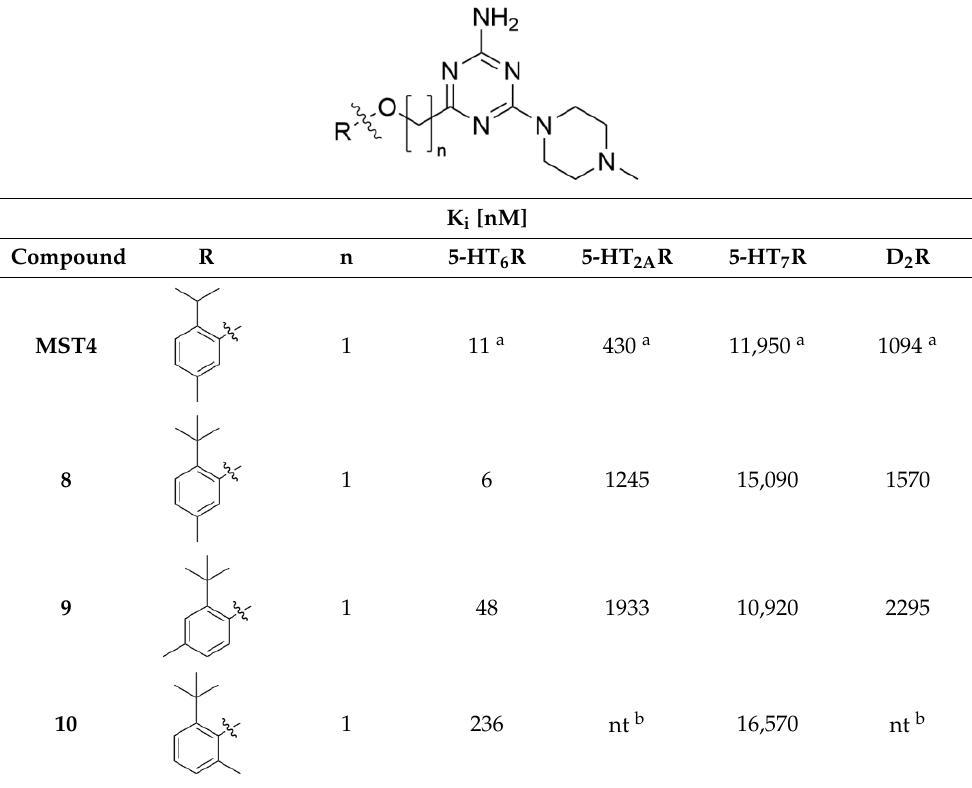
Table 2. Structures and biological activity of tested compounds 8 – 13 (series 2). 1.